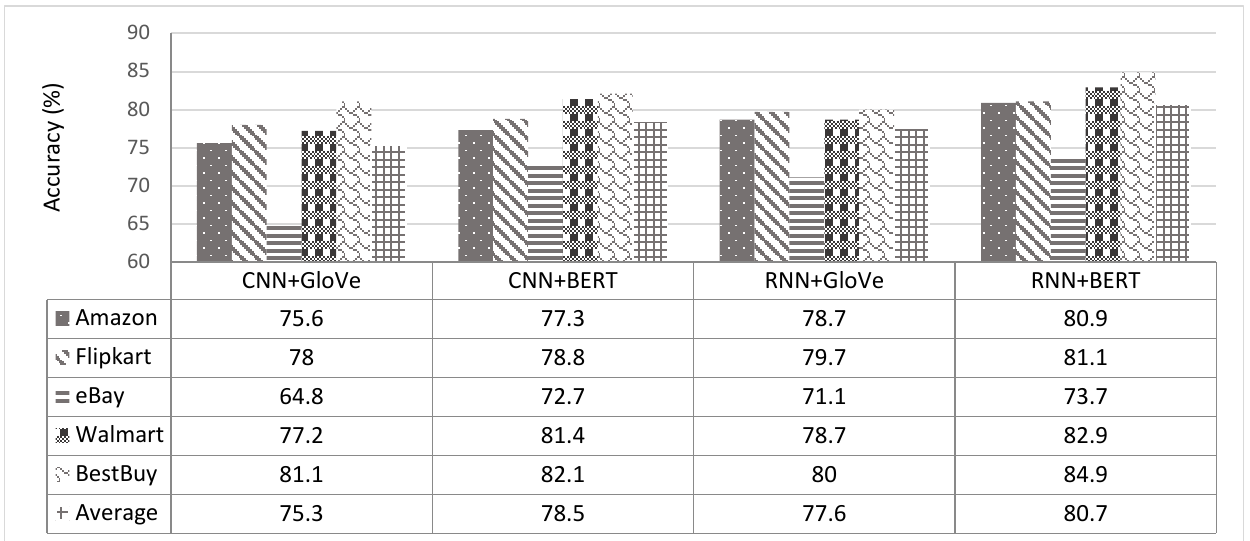
Figure 11. Comparisons of the two word embedding-based deep learning models for our LC5 dataset.